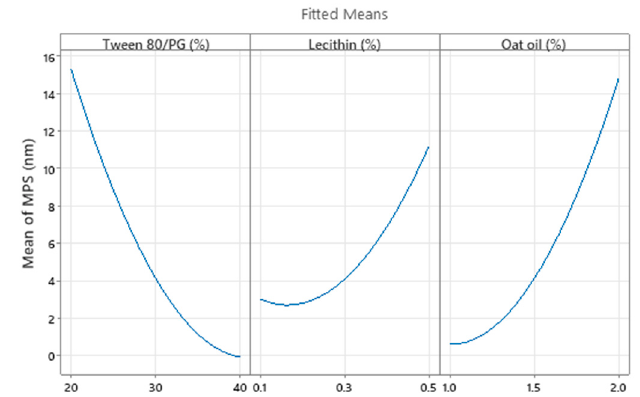
Figure 19. Main effects plot for Ds response (Y 2 ), considering individual effect of each independent variable.